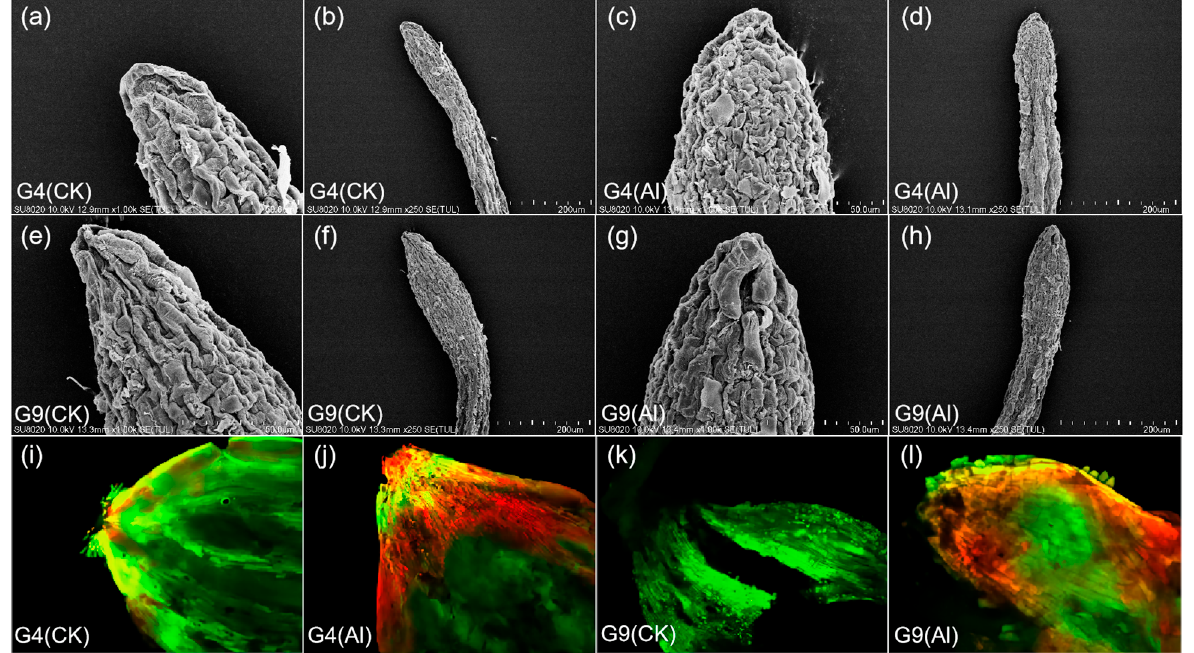
Figure 1. SEM photograph and PCD of root apex of Eucalyptus urophylla (G4) and Eucalyptus grandis × Eucalyptus urophylla (G9) after 24 h of Al stress at different magnifications. ( a , b ) Al-sensitive G4 samples without Al treatment; ( c , d ) G4 samples with Al treatment; ( e , f ) Al-resistant G9 samples without Al treatment; ( g , h ) G9 samples with Al treatment; ( i – l ) root tip cells stained with FDA-PI and observed under a fluorescence microscope, where green fluorescence indicates viable cells and red fluorescence indicates dead cells. ( a , c , e , g , i – l ) 1000× magnification; ( b , d , f , h ) 250× magnification. SEM, scanning electron microscopy, PCD, programmed cell death, FDA-PI, fluorescein diacetate–propidium iodide.